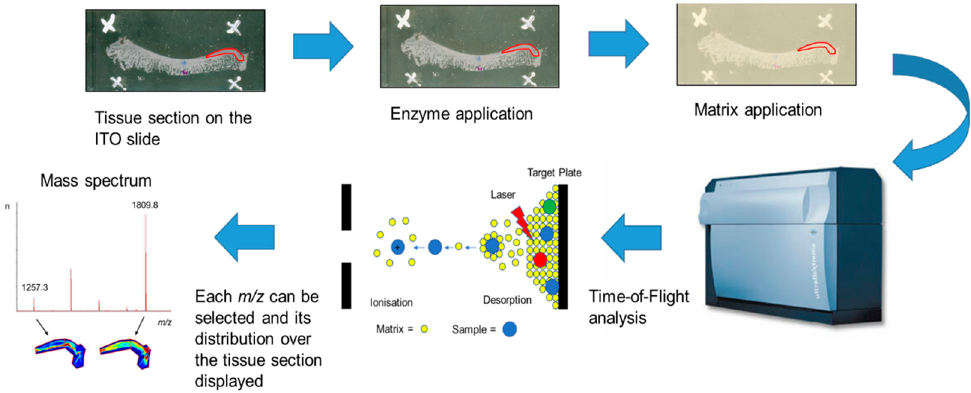
Figure 1. Schematic matrix-assisted laser desorption/ionisation mass spectrometry imaging (MALDI- MSI) workflow for fresh-frozen (FF) or formalin-fixed paraffin-embedded (FFPE) tissue using the “bottom-up” strategy [50]. Tissue is sectioned and mounted onto indium tin oxide (ITO) slides. FFPE tissue sections are deparaffinised followed by antigen retrieval. Then, an enzyme is sprayed directly onto the tissue section followed by matrix deposition, most commonly α